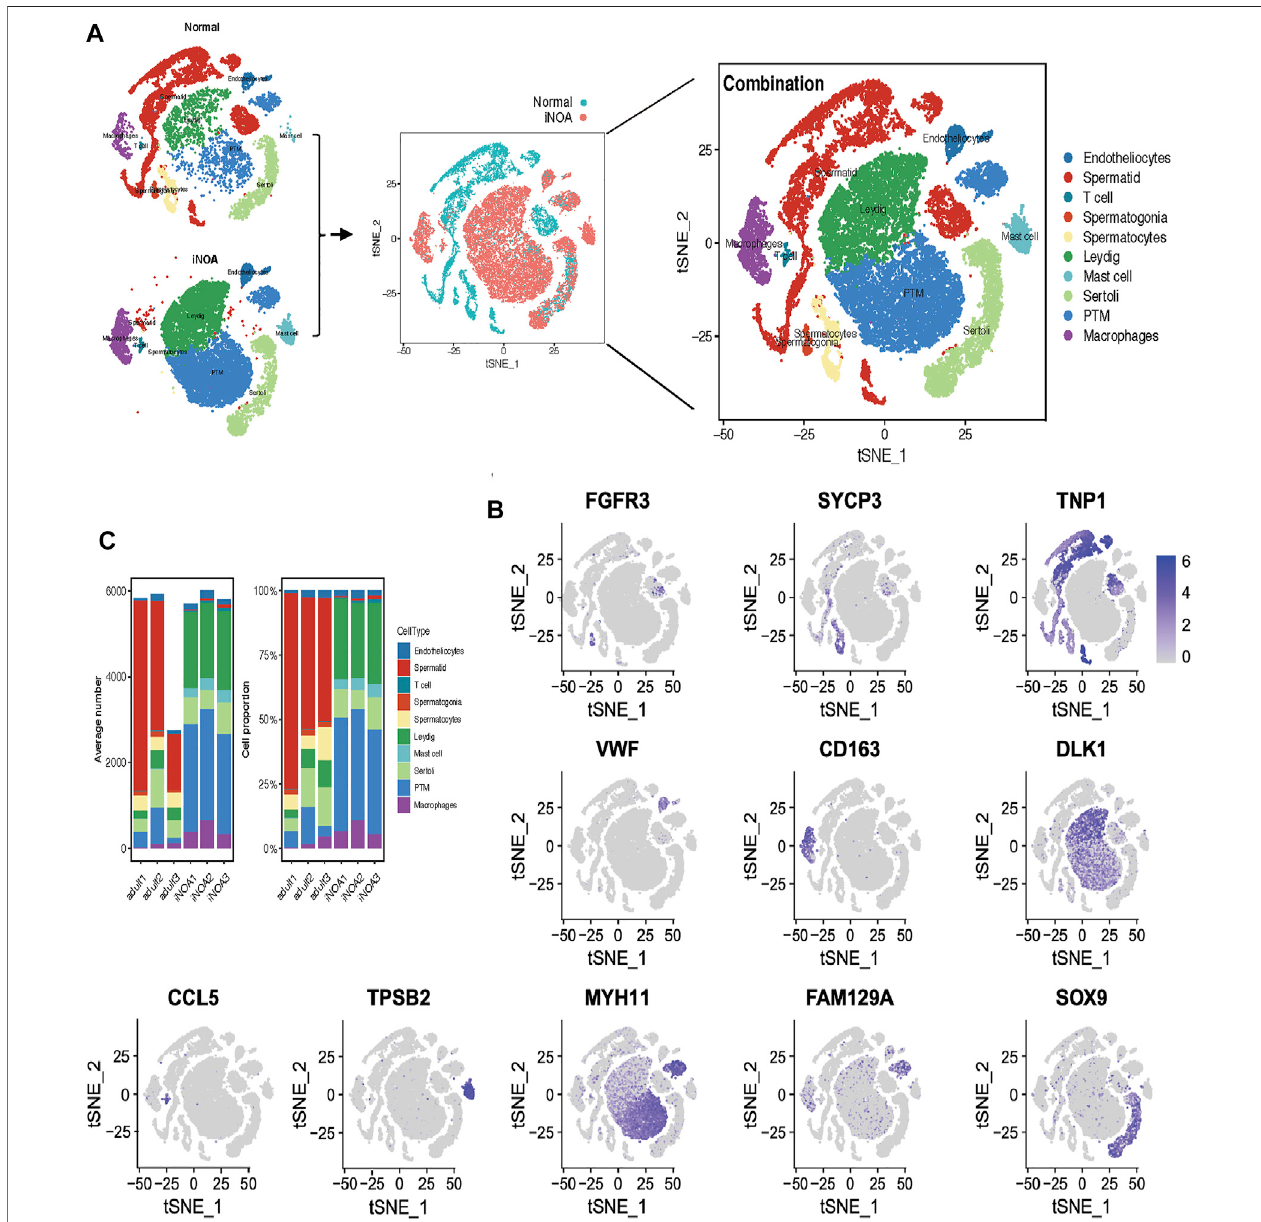
iNOA groups. Ten main cell types were de fi ned, including endotheliocytes, T cells, mast cells, Leydig cells, Sertoli cells, peritubular myoid (PTM) cells, macrophages, spermatogonia, spermatocytes and spermatids. (B) The t-SNE map shows the expression level distribution of marker genes in cell types, including FGFR3 (spermatogonia), SYCP3 (spermatocytes), TNP1 (spermatids), VWF (endotheliocytes), CD163 (macrophages), DLK (Leydig cells), MYH11 (PTM cells), SOX9 (Sertoli cells), CCL5 (T cells) and TPSB2 (mast cells). (C) The mean cell number and relative proportion of testicular subsets from various sample